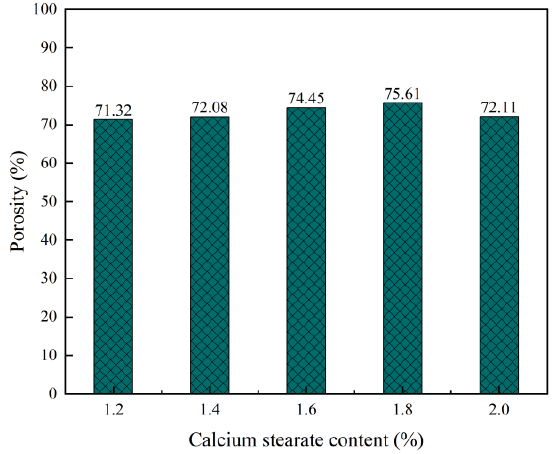
Figure 7. Effect of H 2 O 2 content on pore size distribution frequency of foam concrete.